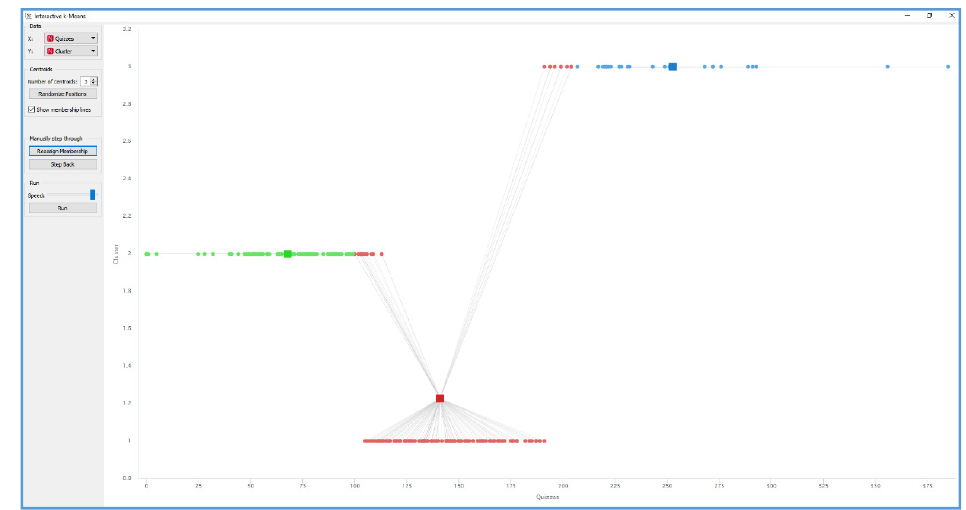
Figure 12. Visualization of student behaviour in the three clusters (1 = Cluster 1; 2 = Cluster 2; 3 = Cluster 3) in the variable quizzes.